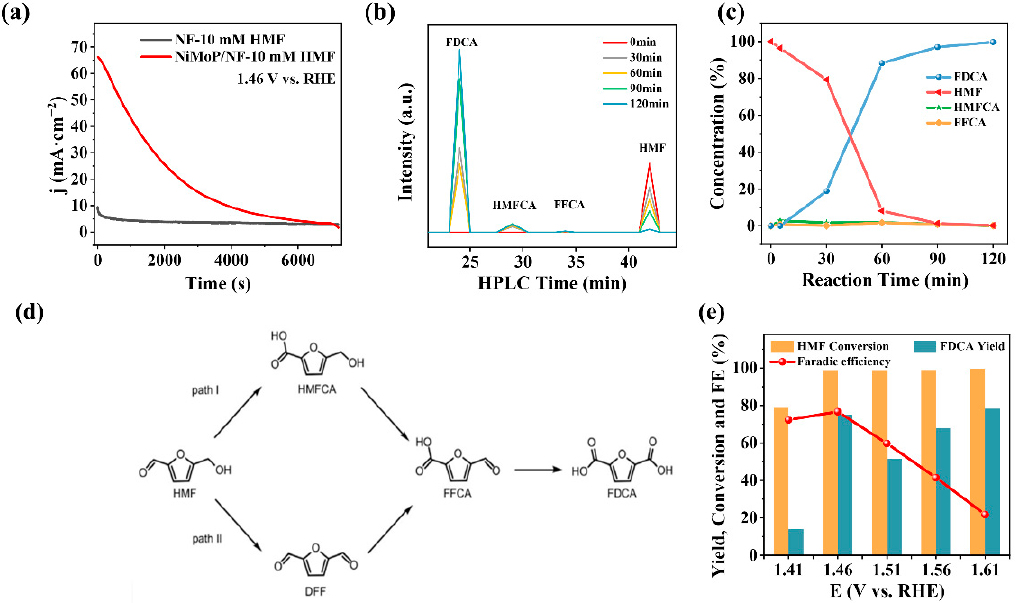
Figure 5. ( a ) Chronoamperometry tests at 1.46 V vs. RHE in a 25 mL 1.0 M KOH solution with 10 mM HMF using NiMoP/NF and NF electrode; ( b ) high-performance liquid chromatography (HPLC) peak height trends at various electrolysis times; ( c ) concentration of HMF and FDCA and the intermediates versus time plot at various electrolysis times; ( d ) two possible pathways of HMFOR under alkaline conditions; ( e ) FDCA yield, HMF conversion, and FE in 1.0 M KOH with 10 mM HMF using NiMoP/NF anode at different applied potentials after 2 h electrolysis.